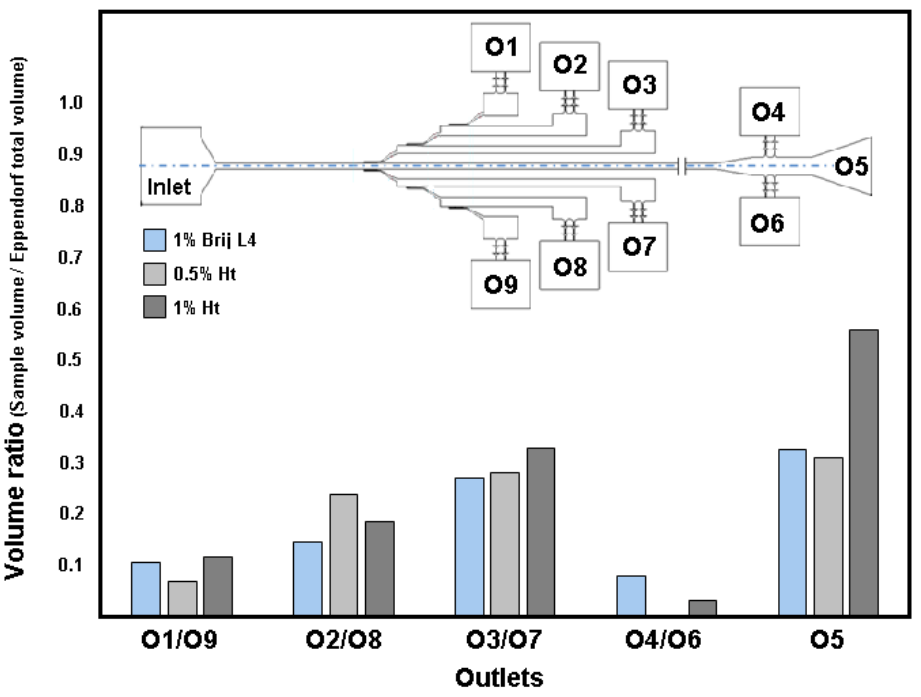
Figure 5. Percentage of fluid collected from the channel after 5 min of continuous flow of Brij L4 BAF and Dextran 40 with 0.5% and 1% Ht for a maximum of 2.5 mL.